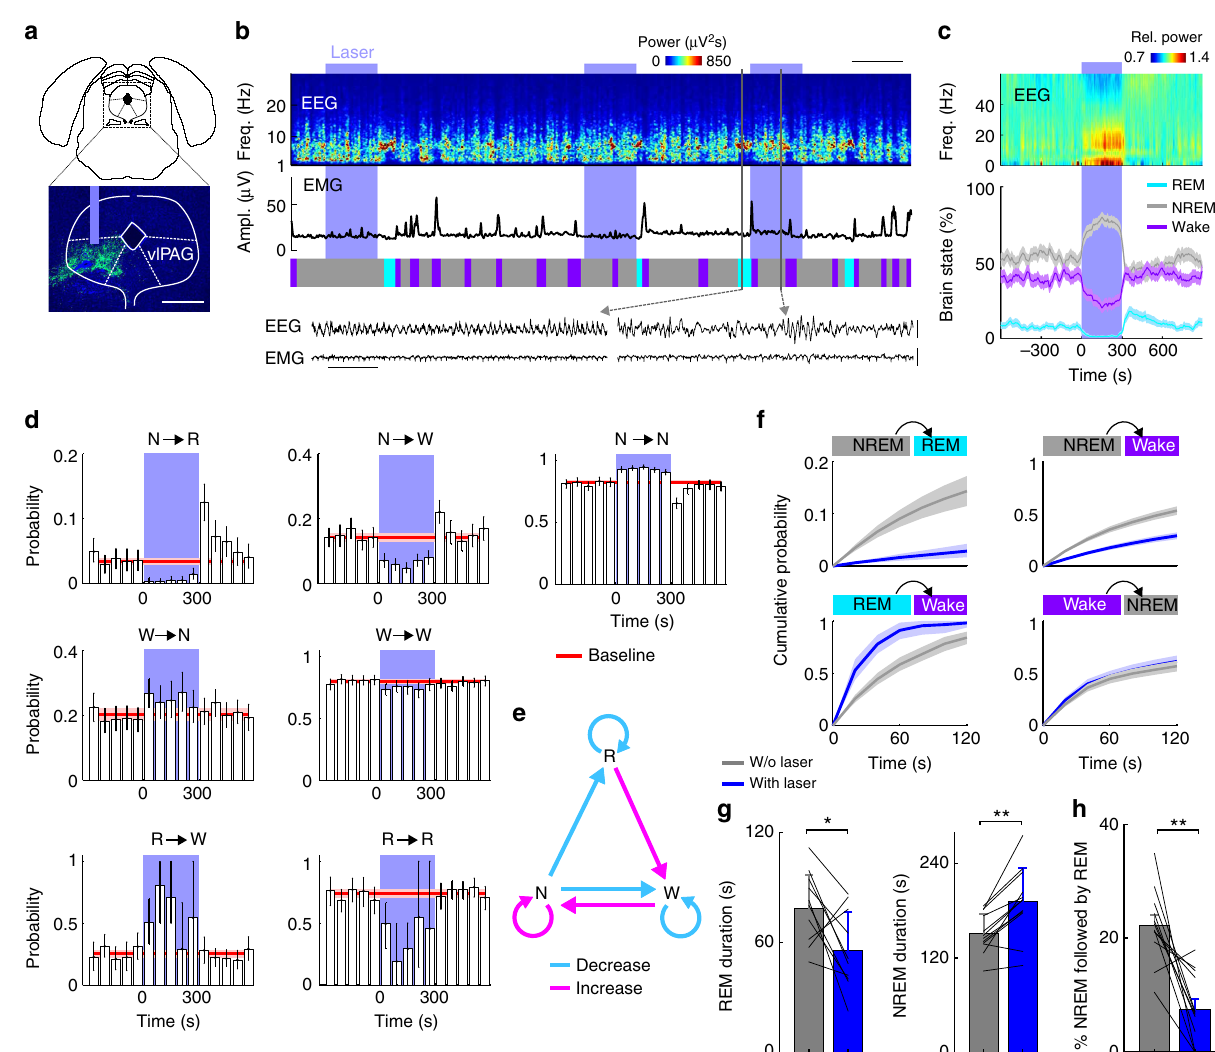
Fig. 1 Optogenetic activation of vlPAG GABAergic neurons suppresses REM sleep and wakefulness while enhancing NREM sleep. a Schematic of optogenetic experiment. Top, coronal diagram of mouse brain; bottom, fl uorescence image of PAG in a GAD2-Cre mouse injected with AAV expressing ChR2 – eYFP (green). Blue, 4 ʹ ,6-diamidino-2-phenylindole (DAPI). Scale bar, 500 μ m. Brain fi gure adapted from Allen Mouse Brain Atlas (© 2015 Allen Institute for Brain Science. Allen Brain Atlas API. Available from: http://brain-map.org/api/index.html). b Example experiment. Shown are EEG power spectrogram (scale bar, 300 s), electromyogram (EMG) amplitude, brain states, and EEG, EMG raw traces on an expanded timescale during the selected time periods (black boxes; scale bars, 1 s and 0.5 mV). Blue shading, laser stimulation period (20 Hz, 300 s). c Average EEG spectrogram (top, normalized by the mean power in each frequency band) and the percentage of wake, NREM, or REM states (bottom) before, during, and after laser stimulation ( n = 12 mice). Laser stimulation increased NREM sleep ( P < 0.0001, bootstrap) and decreased wakefulness ( P < 0.0001) and REM sleep ( P < 0.0001). Shading, 95% con fi dence intervals (CI). Blue stripe, laser stimulation period (20 Hz, 300 s). d Effect of laser stimulation on transition probability between each pair of brain states. Bars, transition probabilities within each 20 s period. Error bar, 95% CI (bootstrap). Red line and shading, baseline and 95% CI. N NREM, R REM, W wake. e Diagram summarizing transition probabilities that are signi fi cantly increased (magenta) or decreased (cyan) by laser stimulation. f Cumulative probability of transition between each pair of brain states within 120 s after the initiation of each brain state with or without laser stimulation. Laser stimulation caused a decrease in NREM → REM ( P < 0.001, bootstrap) and NREM → wake ( P < 0.001) transitions, increase in REM → wake transition ( P < 0.001), and only minor increase in wake → NREM transition ( P = 0.028). Shading, 95% CI. g Mean REM and NREM episode duration for episodes overlapping or non-overlapping with laser ( n = 12 mice). Lines, single mice. * P < 0.05, Wilcoxon signed-rank test. Error bar, ± s.d. ( h ) Percentage of NREM episodes followed by REM, in episodes overlapping or not overlapping with laser. * P < 0.05, ** P < 0.01, Wilcoxon singed-rank test. Error bar ±